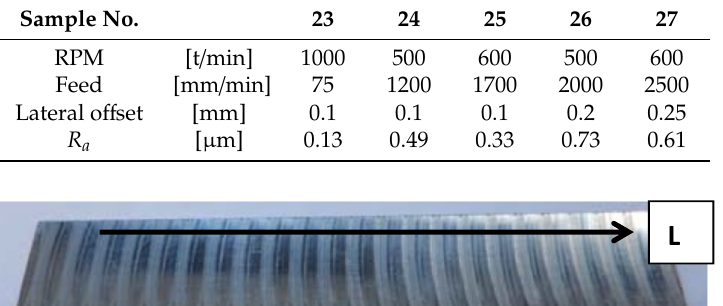
Figure 1. The investigated 22NiMoCr37 samples having different surface roughness conditions. Figure 2. Sample 24. Manufacturing grooves can be clearly seen. Longitudinal orientation is indicated. Table 1. Manufacturing parameters and surface roughness parameters of the measured samples. Sample No.